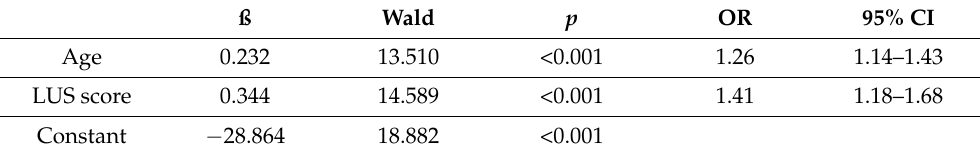
Table 6. Multivariate logistic regression analysis according to mortality.